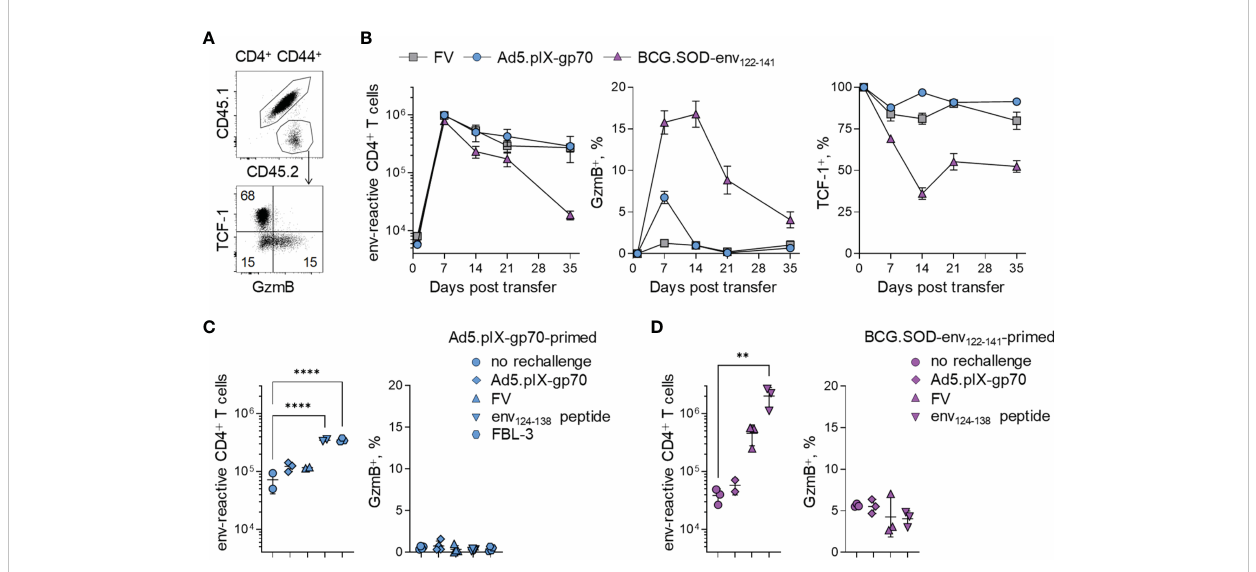
FIGURE 1 Persistence of env-reactive CD4 + CTLs following diverse challenges. (A) Flow-cytometric detection of CD44 + env-reactive donor CD4 + T cells (top) and TCF-1 + and GzmB + CD4 + T cells (bottom) in spleens of WT recipient mice. (B) Absolute numbers (left), GzmB expression (middle) and TCF-1 expression (right) of env-reactive donor CD4 + T cells in the spleens of WT recipient mice at indicated time points after FV infection, or immunization with Ad5-pIX- gp70 or BCG.SOD-env 122-141 . (C) Absolute numbers (left) and GzmB expression (right) of env-reactive donor CD4 + T cells in the spleens of Ad5.pIX-gp70- primed mice at day 7 after re-challenge with indicated stimuli. (D) Absolute numbers (left) and GzmB expression (right) of env-reactive donor CD4 + T cells in the spleens of BCG.SOD-env 122-141 -primed mice at day 7 after re-challenge with indicated stimuli. **p < 0.01; ****p <